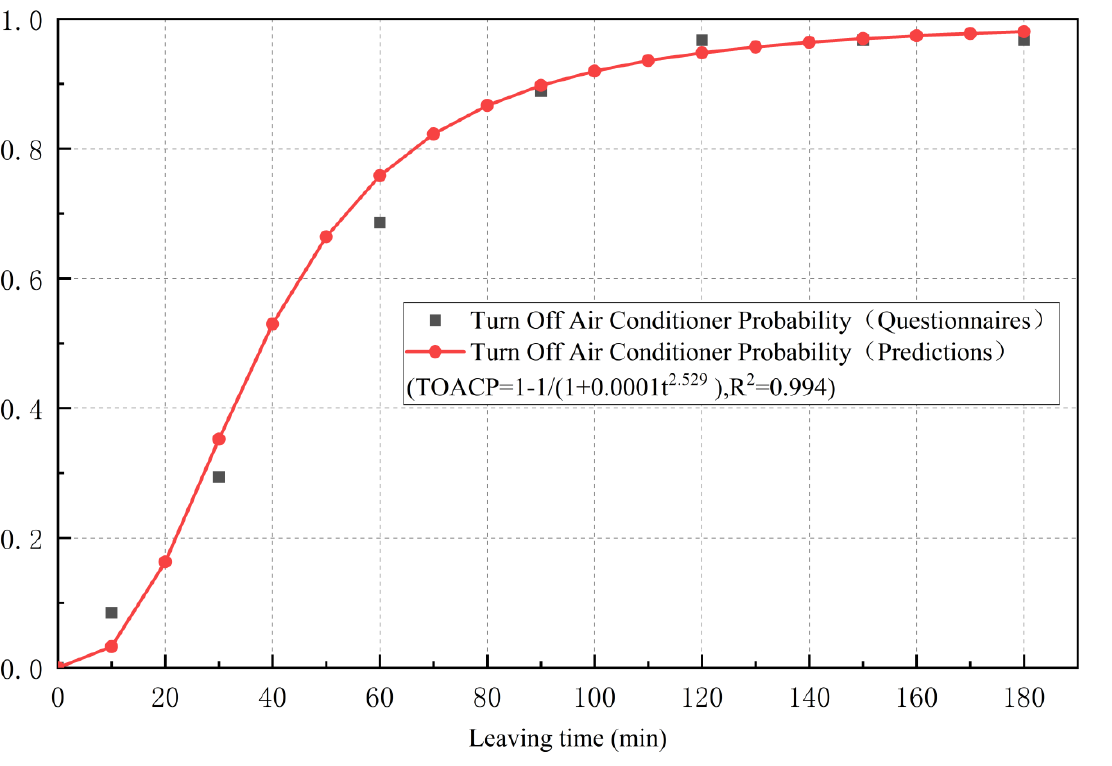
Figure 10. Variation in the TOACP with the length of time the occupant is